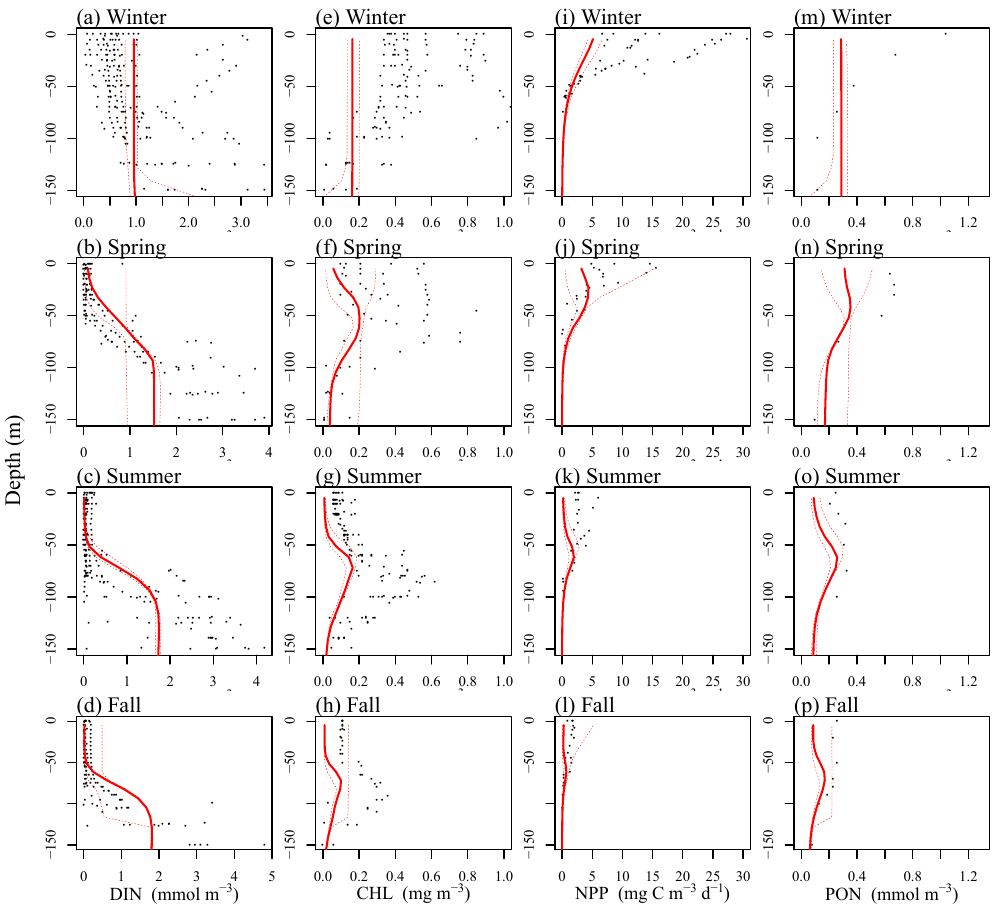
Figure 7. The same as Fig. 6, but for station